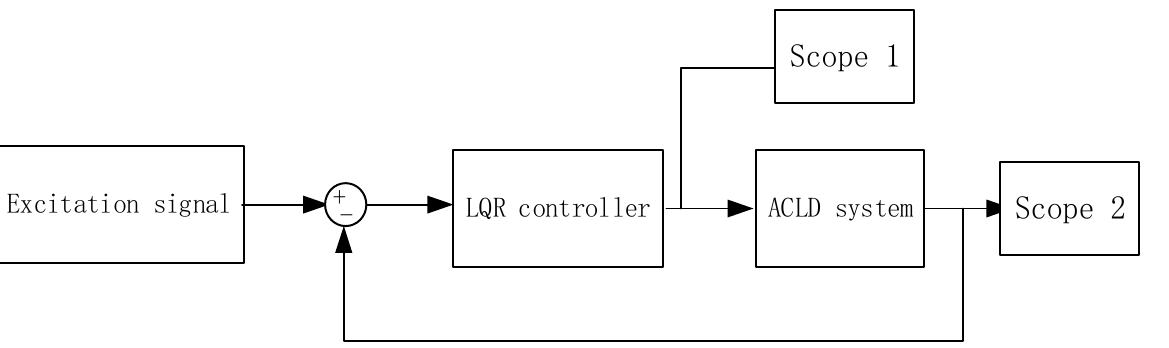
Figure 12. ACLD system control block diagram.